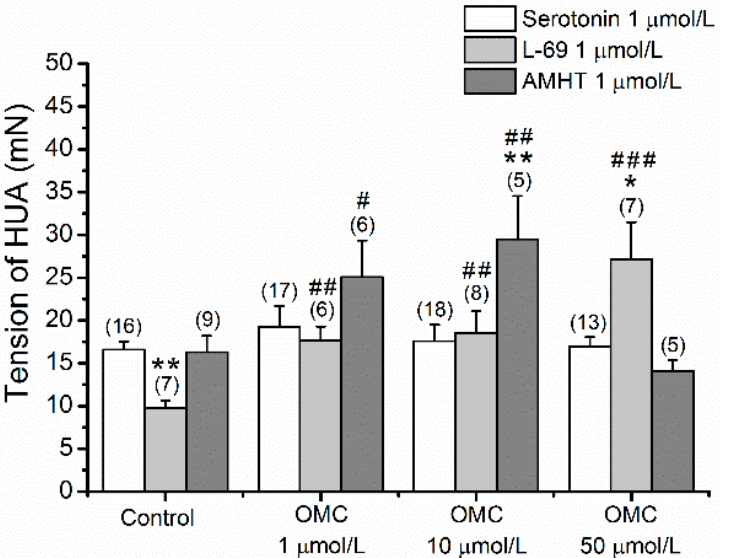
Figure 3. Tension of the human umbilical artery (HUA)-rings incubated with octylmethoxycinnamate (OMC) and contracted by serotonin (5-HT; 1 μ mol/L), L-694247 (L69, 5-HT1 B/D agonist; 1 μ mol/L), and by alpha-methyl-5-hydroxytryptamine (AMHT, 5-HT 2A agonist; 1 μ mol/L). Each bar represents the mean, vertical lines represent the S.E.M., and the number within brackets is n . * Rep- resents a significant difference when compared to the tension induced by 5-HT: ** ( p < 0.01), and # represents a significant difference when compared to the tension of control group: # ( p < 0.05), ## ( p < 0.01) and ### ( p < 0.001); two-way ANOVA method followed by Holm–Sidak post hoc tests